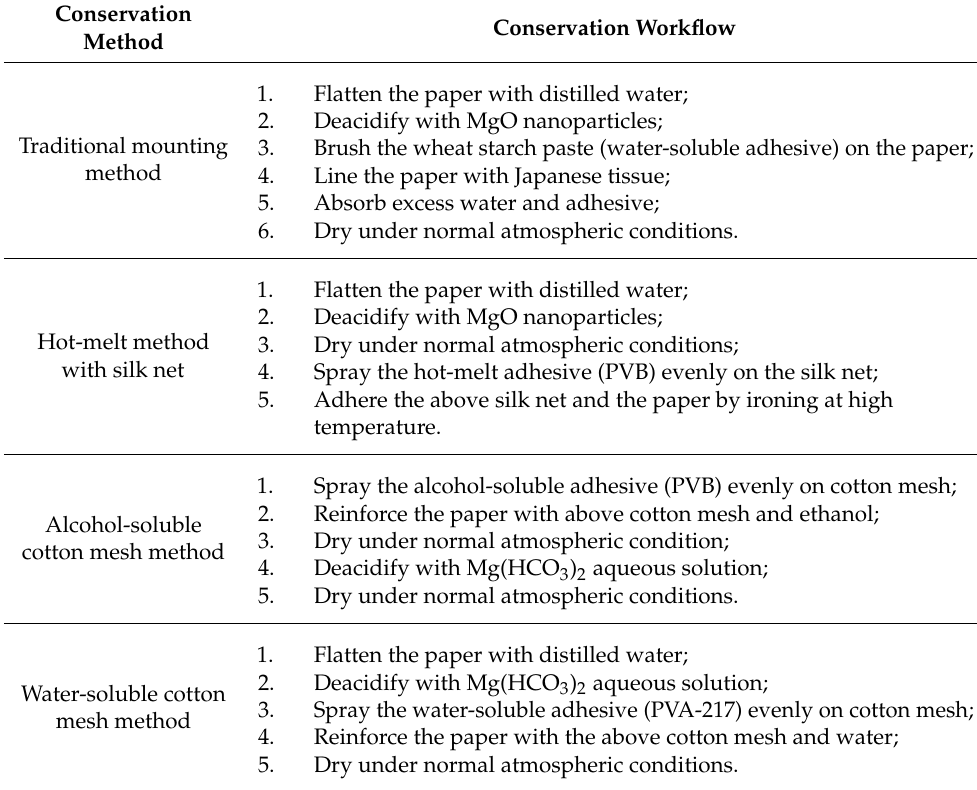
Table 1. Comparison of four popular conservation